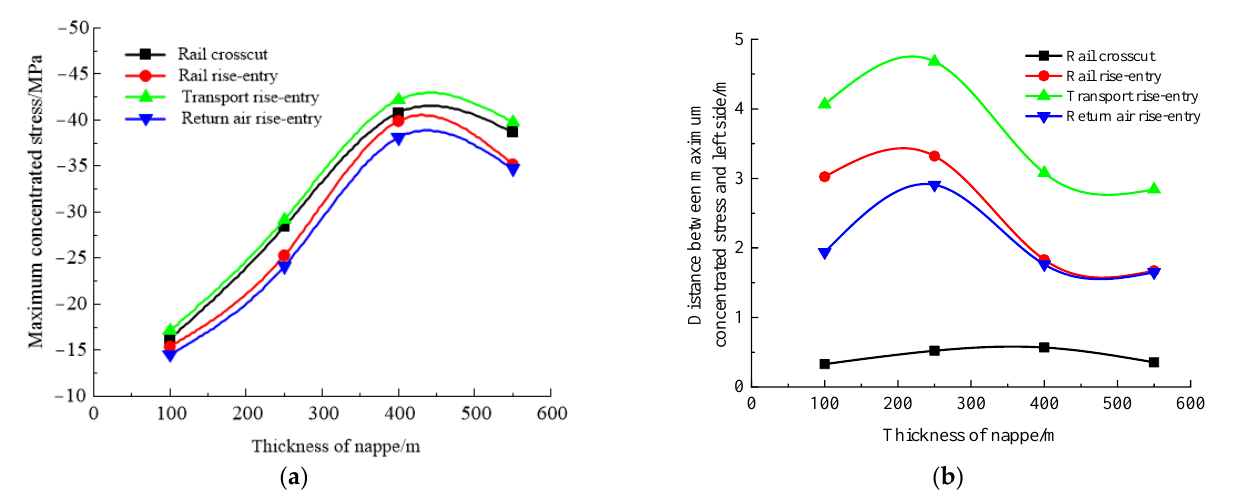
Figure 11. Maximum concentrated stress and its location monitoring results under the different thicknesses of nappe conditions. ( a ) Maximum concentrated stress, ( b ) Position of maximum concentrated stress.